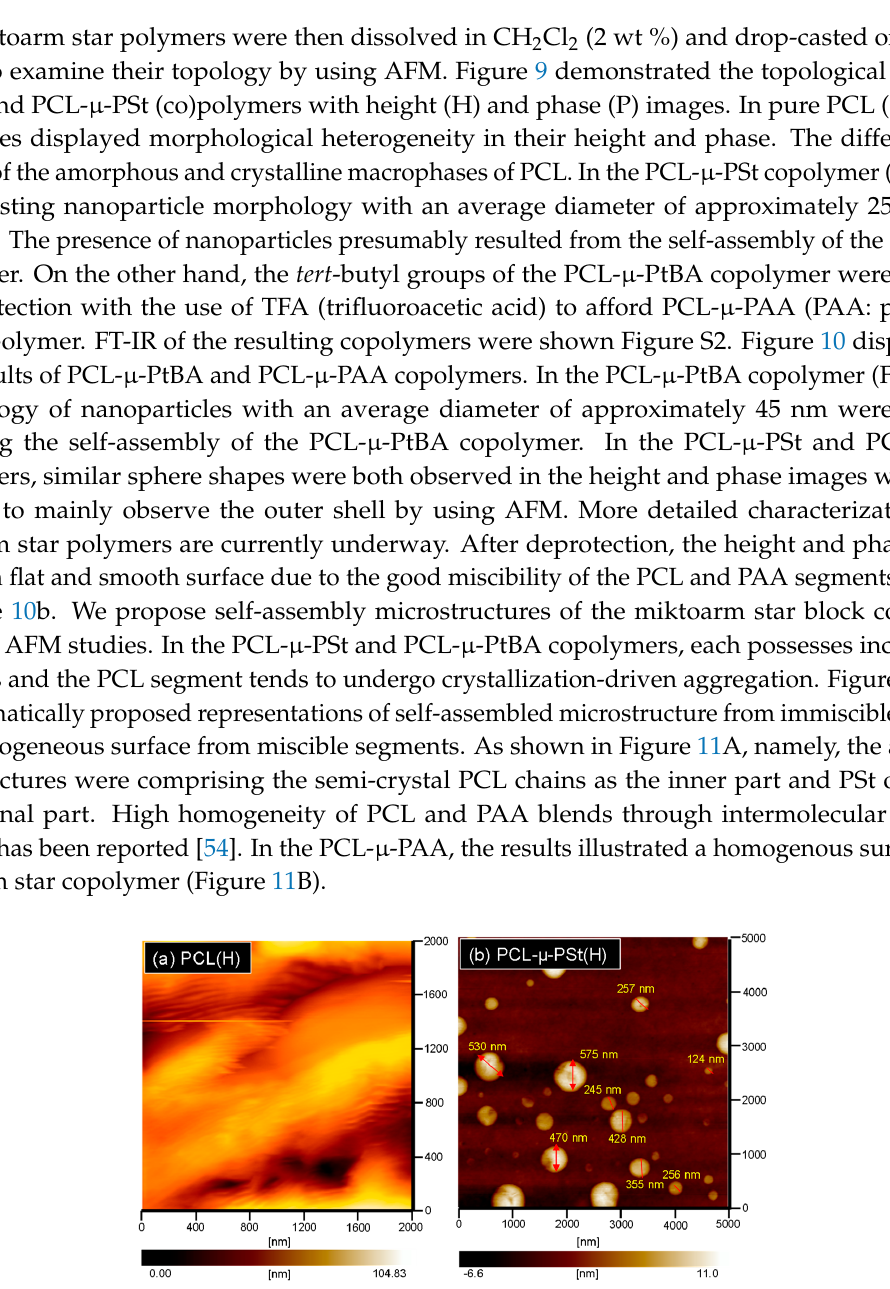
Figure 10. AFM images of ( a ) PCL- μ -PtBA and ( b ) PCL- μ -PAA star copolymers (H: height and P: phase).